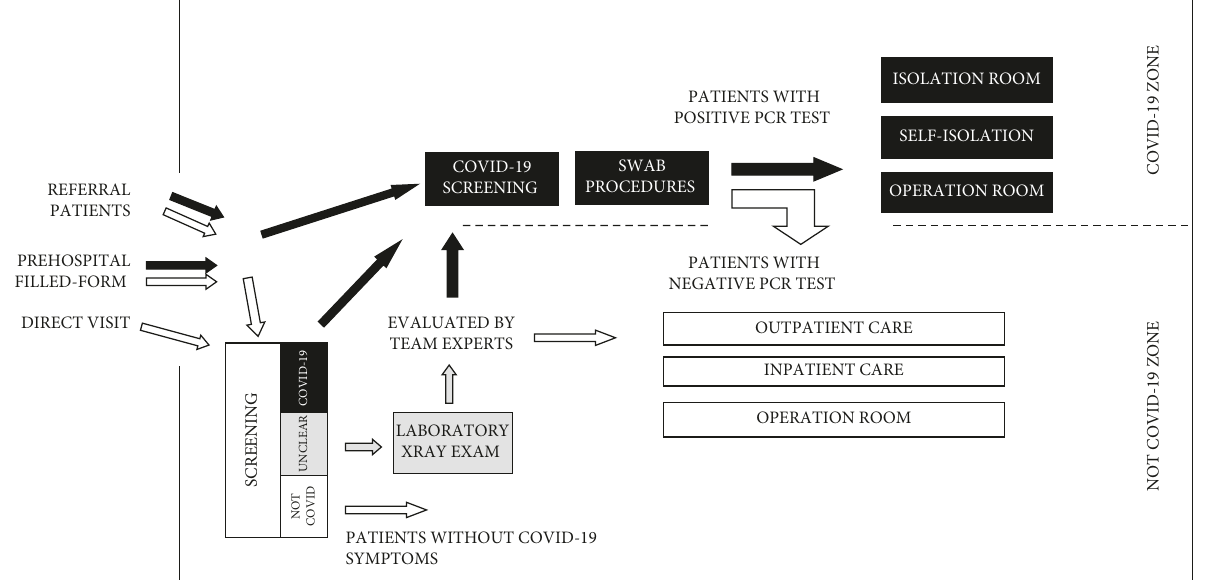
Figure 2: The screening process for COVID-19 in pediatric patients at our facility. Table 1: Clinical characteristics of confirmed and non-COVID-19